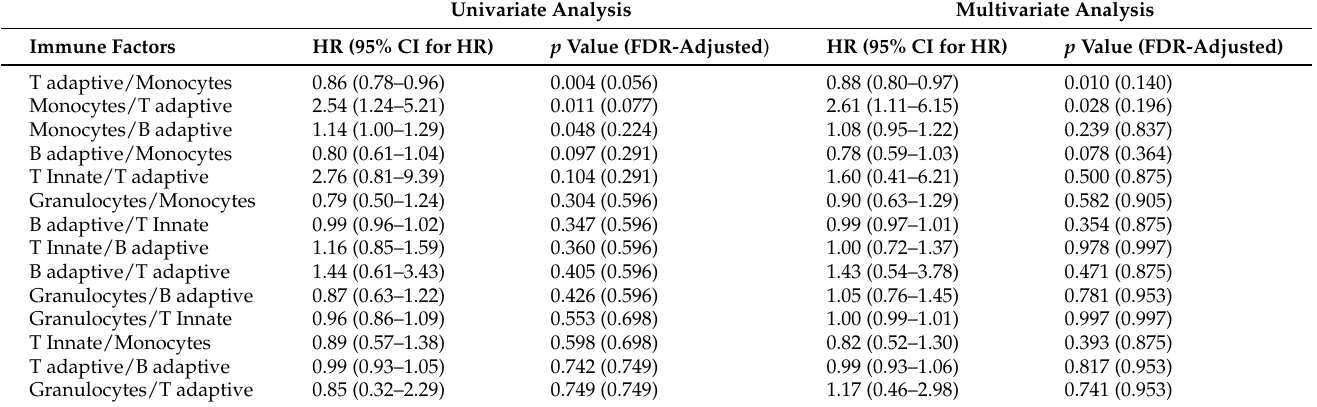
Table 2. Univariate and multivariate results in Cox proportional hazards analysis of immune factors in the training cohort. The p value was derived from the Cox regression model; FDR-adjusted, multiple-comparison-adjusted p values calculated by false discovery rate